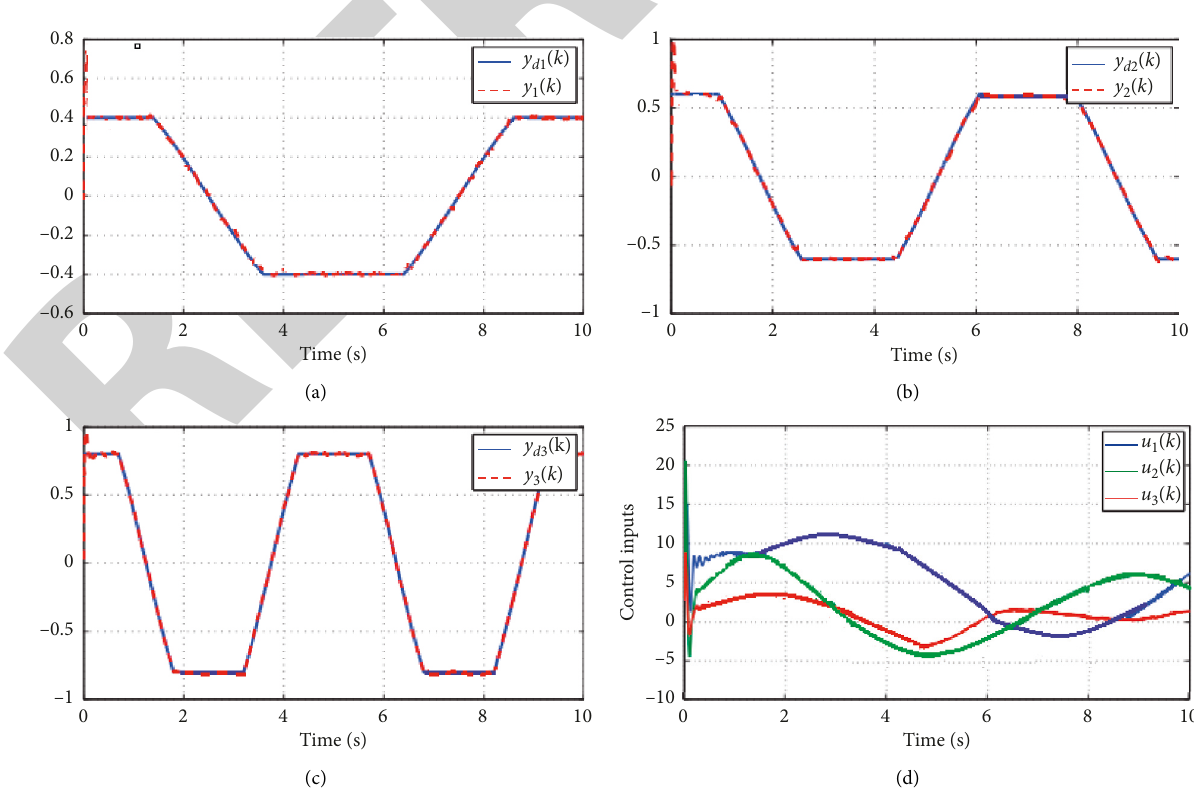
Figure 5: Performance of model-free adaptive sliding model control combined with neural network control of three joints. (a) Tracking performance of y 1 ( k ). (b) Tracking performance of y 2 ( k ). (c) Tracking performance of y 3 ( k ). (d) Control inputs of u 1 ( k ), u 2 ( k ) and u 3 ( k